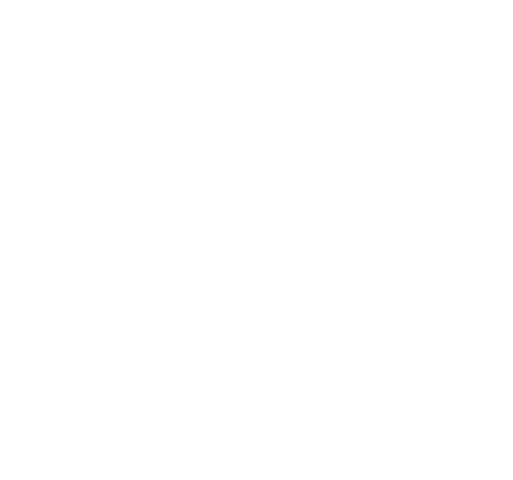
Figure 9. Temperature dependence of the jump distance for the slow mobile water at 238, 253, 268, and 283 K (depicted as circles), and for the fast mobile water at 283 K (depicted as squares), as obtained from the relationship l = √6𝐷𝜏 . The errors estimated from the fitting procedure are indicated by bars.